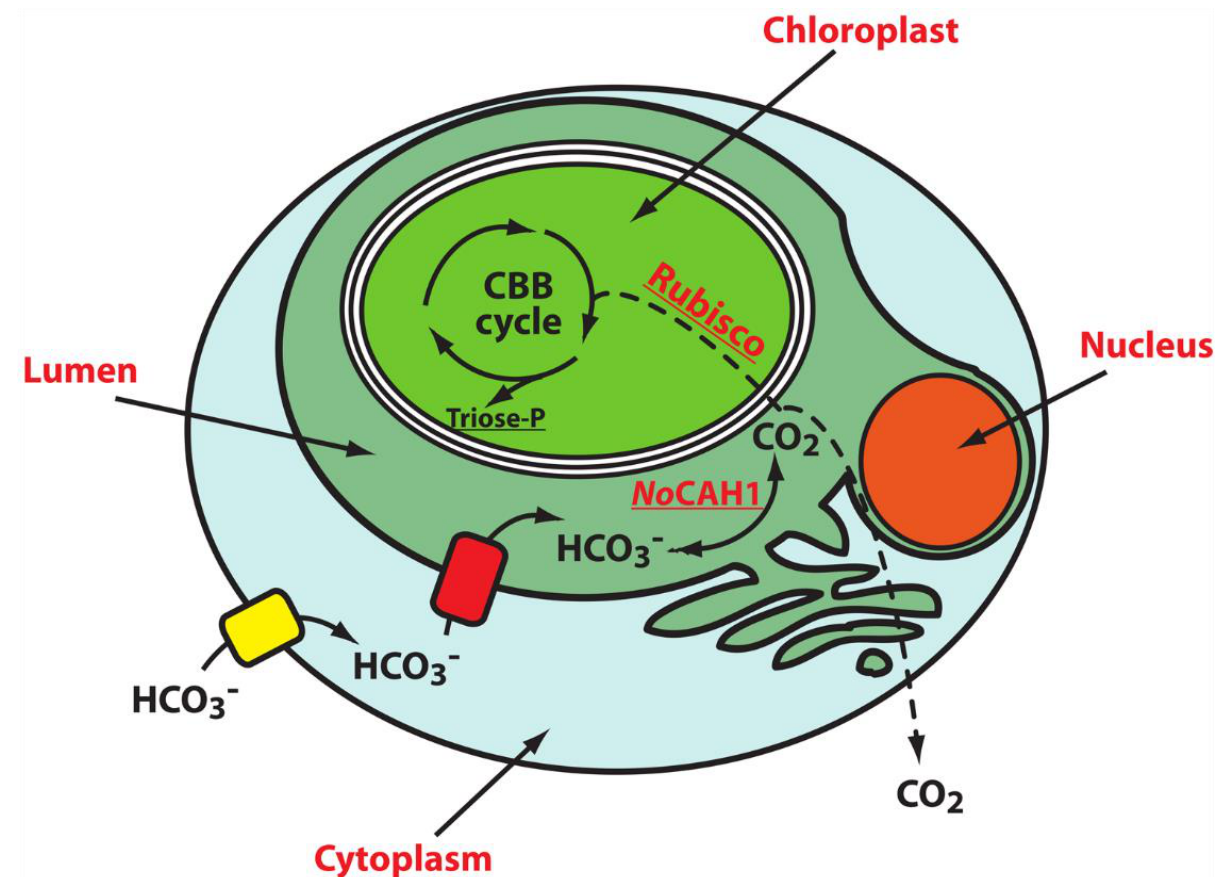
Figure 6. Proposed model for the N. oceanica CCM. The chloropast is separated from the cytoplasm by four membranes, the outermost of which, called the chloroplast ER (cER) membrane, is connected to the nuclear envelope and the ER membrane. Bicarbonate transporters push bicarbonate into the cytoplasm and then into the ER lumen, where No CAH1 is localized. Here, this enzyme catalyzes the formation of CO 2 , which can either diffuse into the chloroplast stroma to be fixed by Rubisco in the Calvin–Benson–Bassham (CCB) cycle, or escape from the cell (dark blue and light blue rectangles represent bicarbonate transporters).